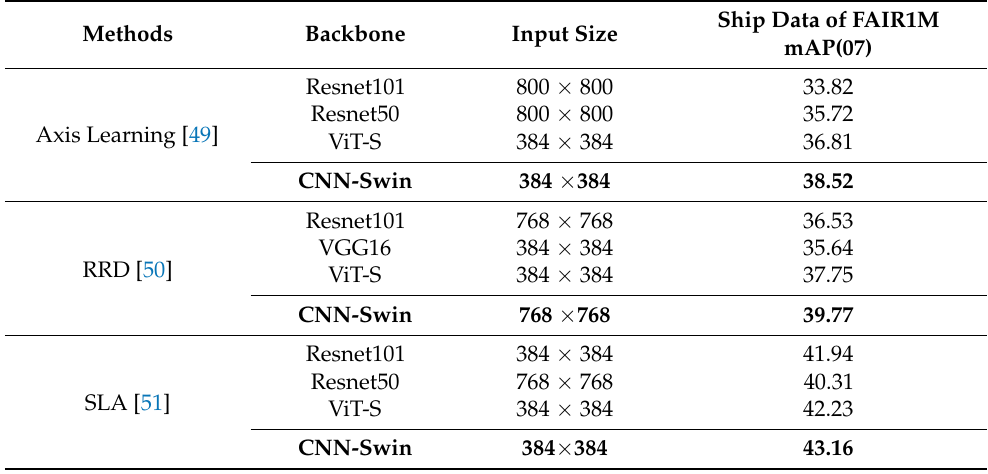
Table 5. Performance comparison of different methods with different backbones for ship detection in the ship data of the FAIR1M dataset.